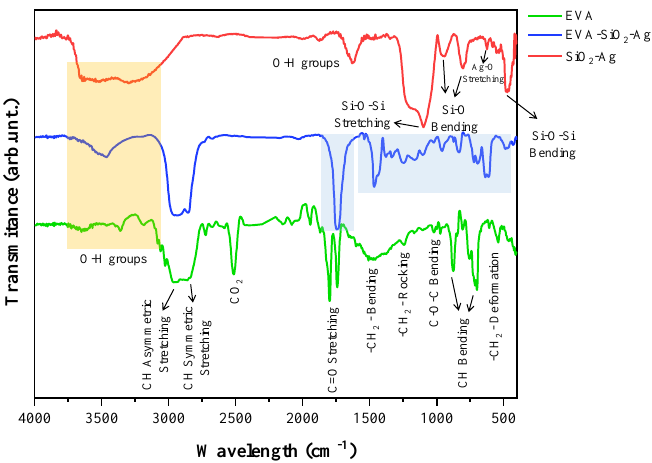
appearance of new ones. These findings indicate the interactions between the polymer, at short and long range, with the particles of SiO 2 and Ag.